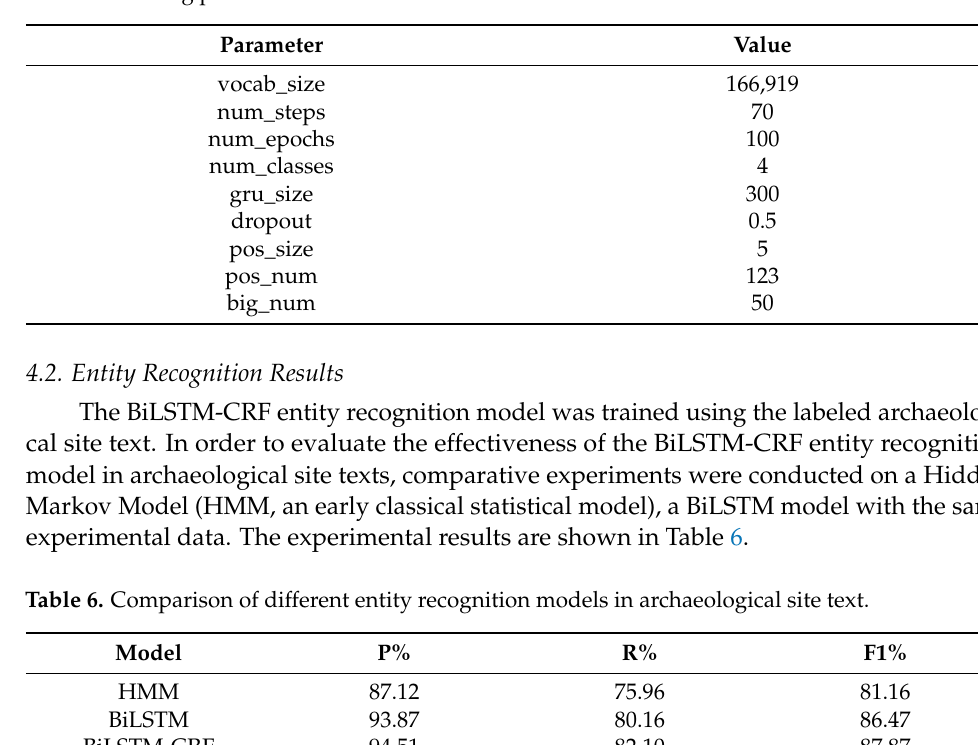
Table 5. Training parameters of the BiGRU-Dual Attention model.